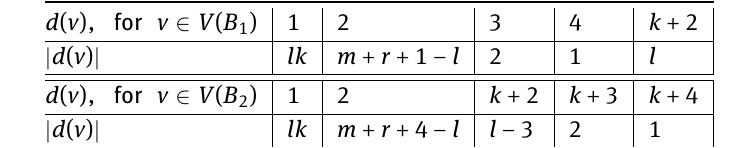
Table 2: Vertex-partitions of the tricyclic graphs B 1 and B 2